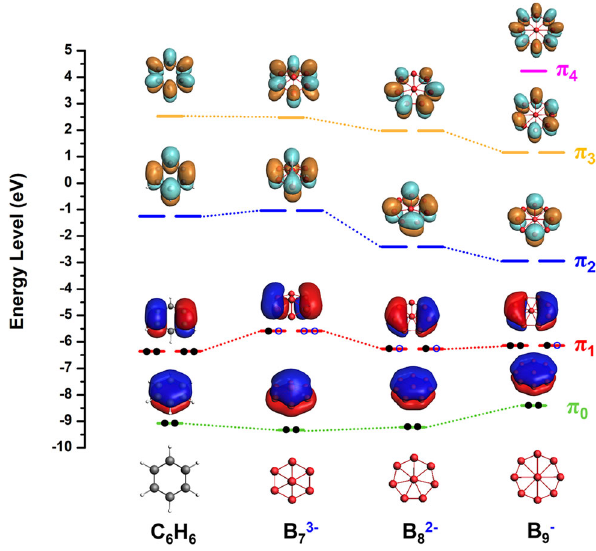
Fig. 5 Comparison of the π orbitals of C 6 H 6 with those of borozenes, B 7 3 − , B 8 2 − , and B 9 − with different nodal planes. Black solid dots correspond to occupied electrons for the neutral species and blue circles represent the additional electrons in the closed-shell anions in the